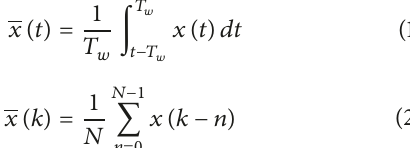
= 0.01 s and N = 100. w